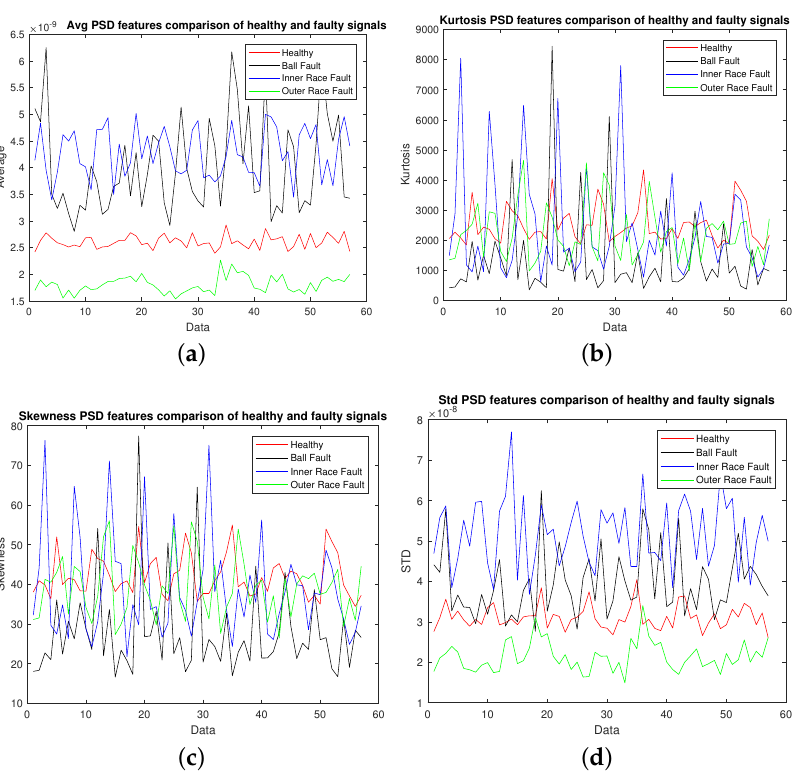
Figure 5. PSD signal demonstration: ( a ) Average, ( b ) Kurtosis, ( c ) Skewness, ( d ) Standard Deviation.